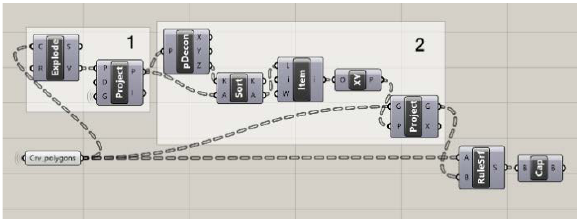
Figure 8. The part of code to construct the volumes